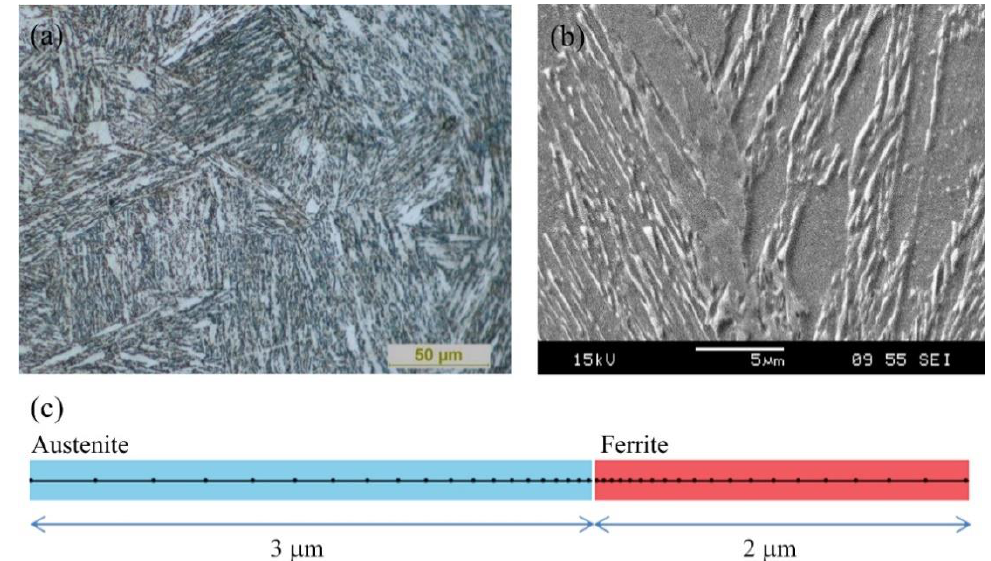
Figure 4. ( a ) Optical microscopy (OM) and ( b ) SEM pictures of samples quenched to 350 °C; ( c ) rectangular model with linear mesh assumed for 3 μ m austenite and 2 μ m martensite.